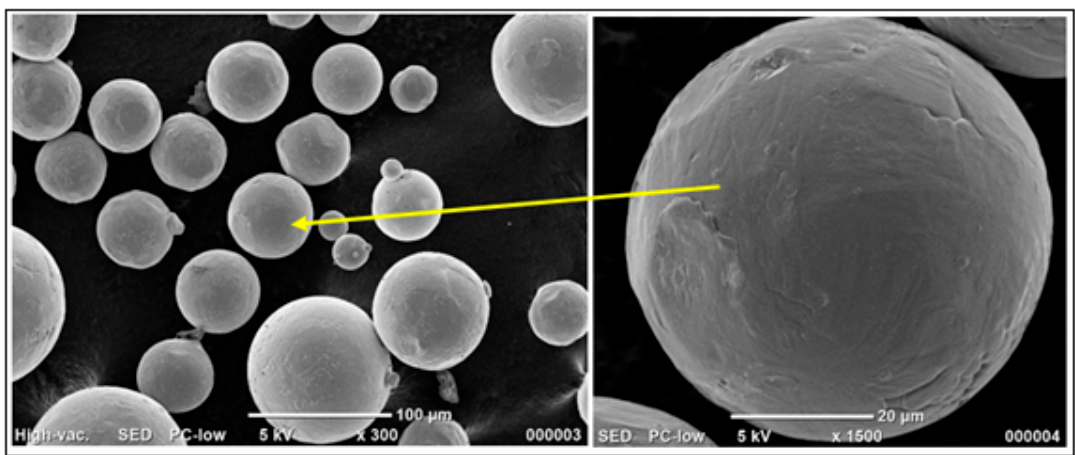
Figure 4. Scanning electron microscope image of Ti6Al4V powder particles.